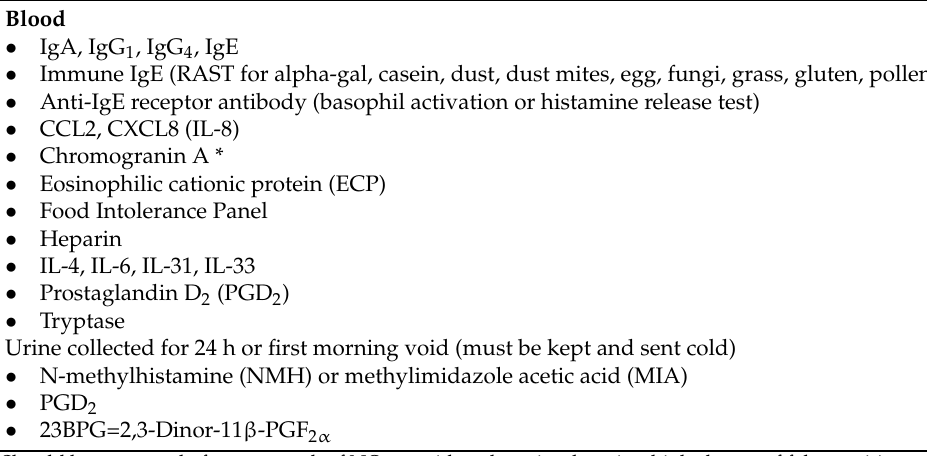
Table 3. Laboratory Tests for Diagnosis of Atopic